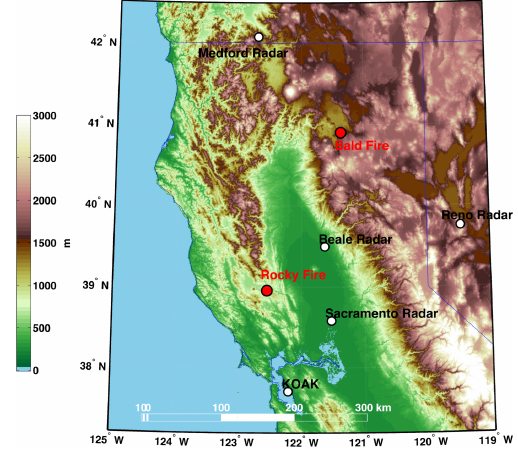
Figure 1. Overview map showing the regional topography (terrain shading), locations of the Rocky Fire and the Bald Fire (red cir- cles), the locations and names of the NWS radars used in the plume analysis (white circles), and the KOAK sounding site (white